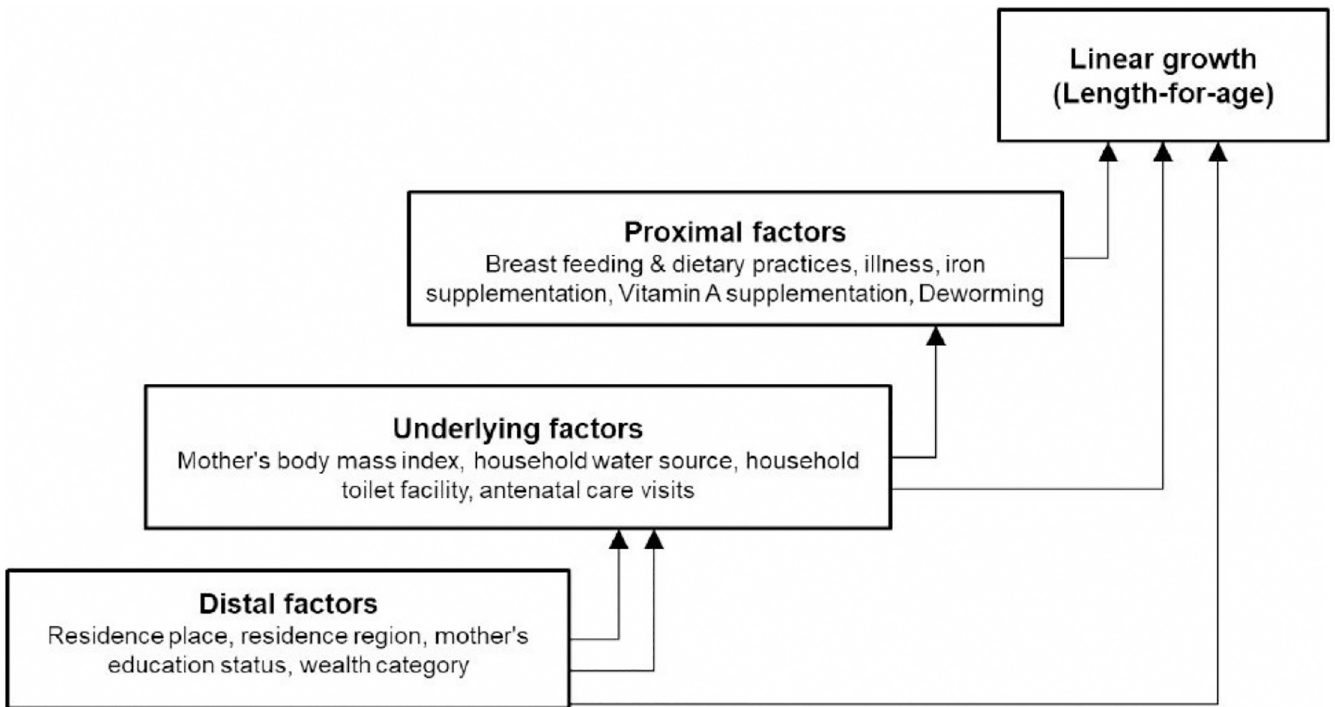
Fig 1. Conceptual framework of factors influencing linear growth